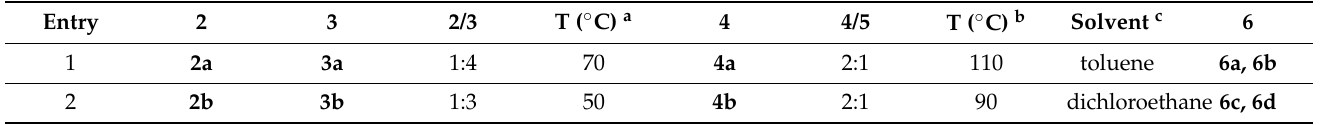
Table 1. Reaction conditions for the synthesis of surfactants 4 and 6 .